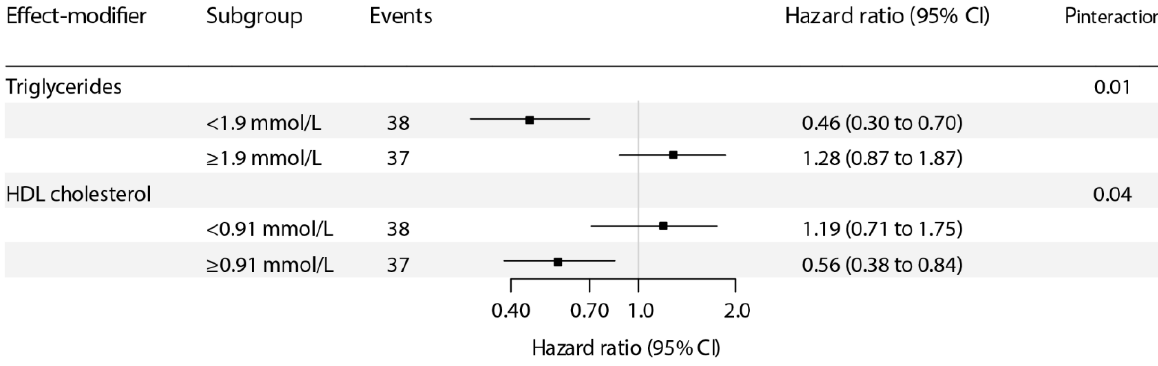
Figure 2. Stratified prospective analyses of the association of plasma vitamin C with risk of graft failure. p interaction was calculated by fitting models, which contain both main effects and their cross-product term, with adjustment for age, sex, body mass index, donor age, donor sex, estimated glomerular filtration rate (eGFR), and proteinuria. Hazard ratios (95% CI) are calculated per 1–SD increment in plasma vitamin C.